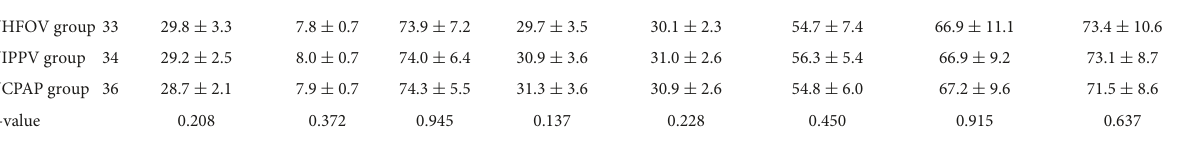
TABLE 2 Pulmonary functional tests at 12-month corrected age.